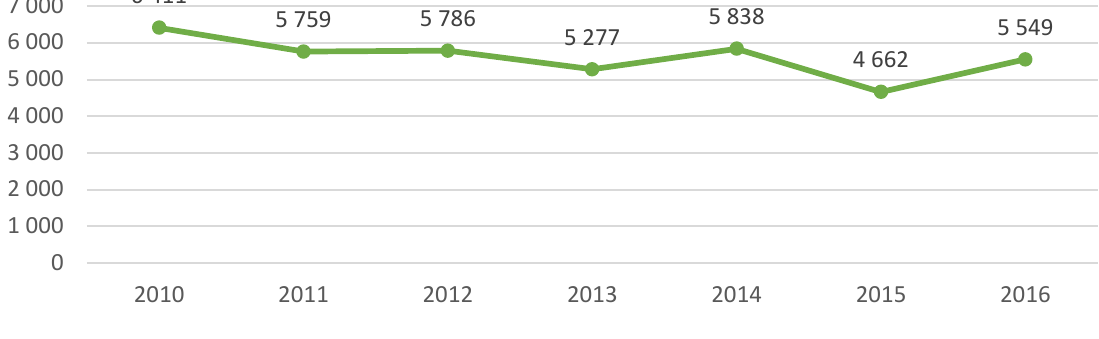
Figure 1. Average Share Prices of Companies has implemented CG and